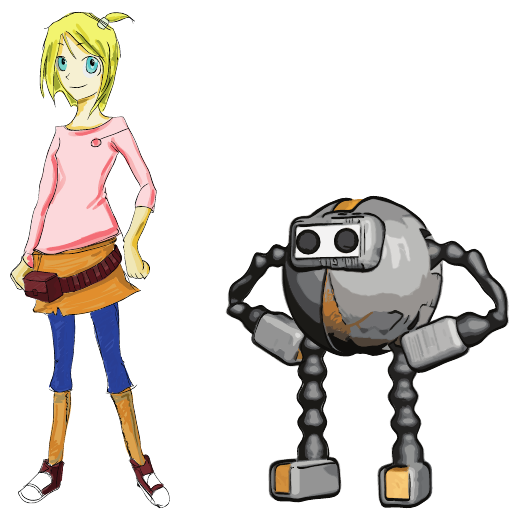
Figure 2: Concepts of Kate and Boris created by the 2D artist.